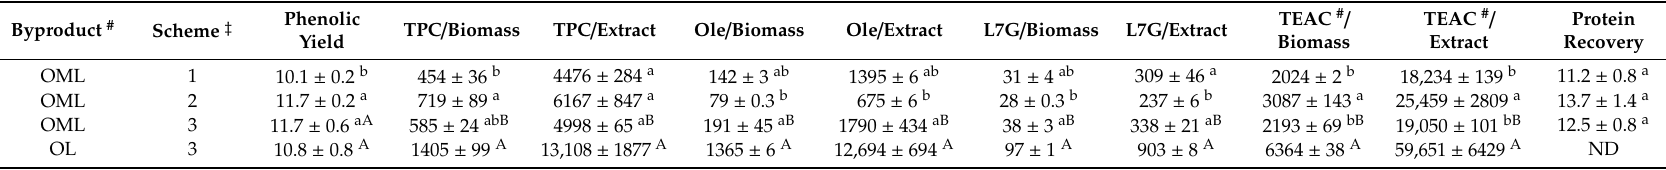
Table 2. Total phenolic yield (%), total phenol content (TPC) (mg gallic acid equivalents / 100 g), oleuropein (Ole) content (mg / 100 g), luteolin 7- O -glucoside (L7G) content (mg / 100 g) and antioxidant activity ( µ mol trolox equivalents / 100 g) of the ethanolic extracts as well as protein recovery (%) after alkaline extraction obtained by three di ff erent sequential extractions